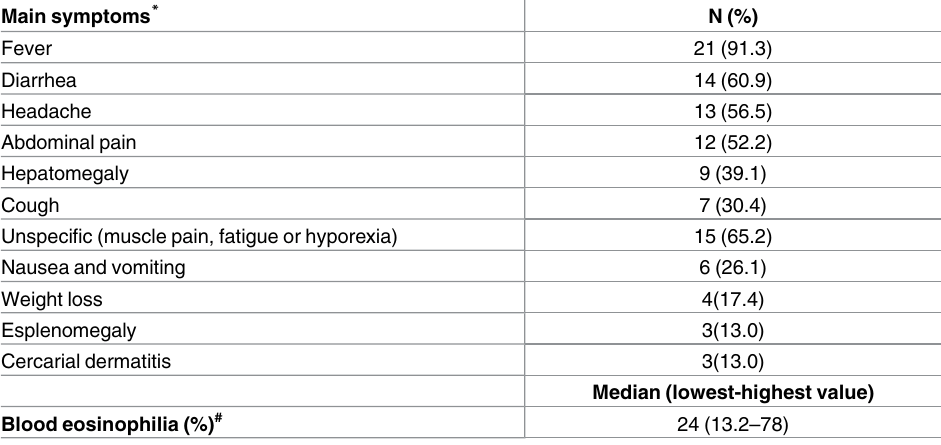
Table 1. Main symptoms and blood eosinophils in patients with acute schistosomiasis mansoni diagnosed at Tropical DiseasesOutpatient Clinic of the University Hospital of Universidade Federal de Minas Gerais (Belo Horizonte, Brazil) from January 2014 to December2015 and included in the study. Main symptoms